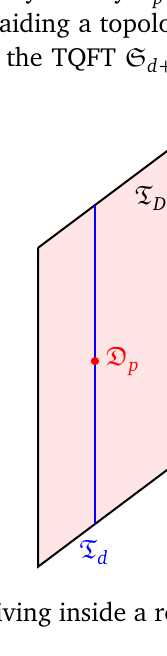
of the abso- p ∈ L with a d − p − 2 d − p − 1 arises at the end of α p p